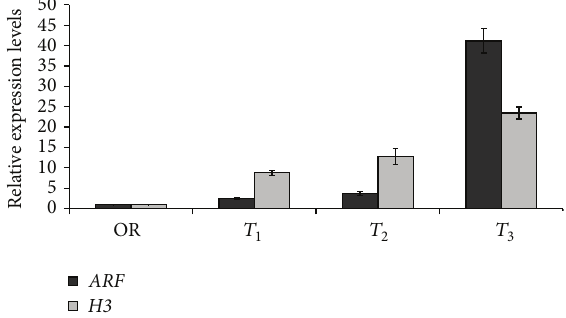
Figure 5: Levels of OesARF and OesH3 erspression in stem cuttings of Olea europaea subsp. europaea var. sylvestris grown for 4 days on different media. Control: stem cuttings were processed immediately after cutting; 𝑇 1 : OR medium without IBA; 𝑇 2 : short pretreatment with 14.7 mM IBA sterile solution and inoculation into the OR medium supplemented with 0.5 mg/L IBA; 𝑇 3 : short pretreatment with 14.7 mM IBA sterile solution and inoculation into the OR medium supplemented with 1mg/L IBA. The levels of OesARF and OesH3 (log scale) were normalized to H 2 b histone gene and compared with the control condition. Data shown are averages of three biological replicates, with error bars representing